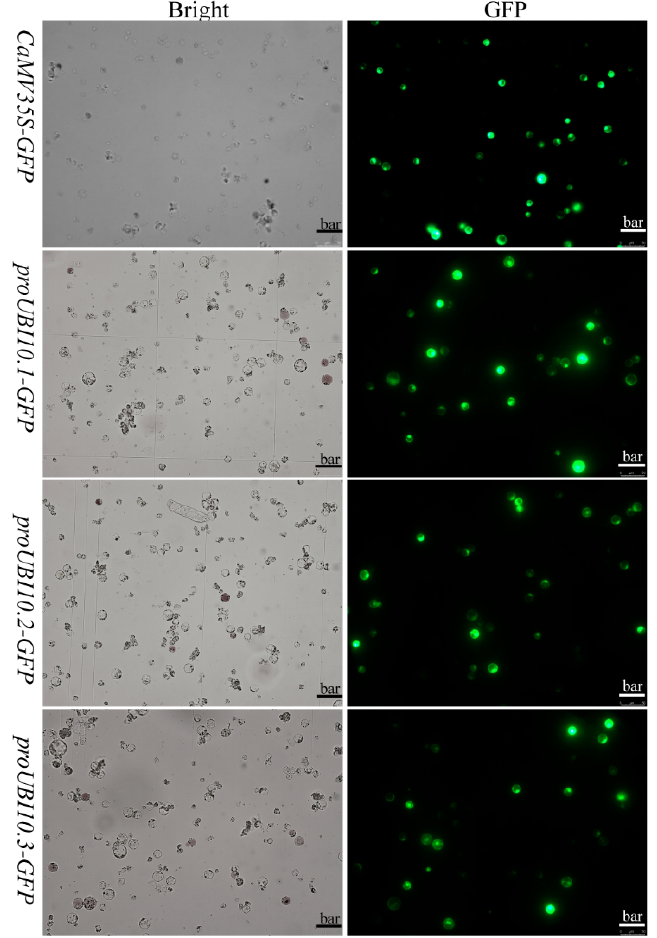
Figure 4. Transient expression assays in Hevea mesophyll protoplasts. Transformation efficiencies were calculated from three replicates. Size bars indicate 50 µm. were calculated from three replicates. Size bars indicate 50 µ